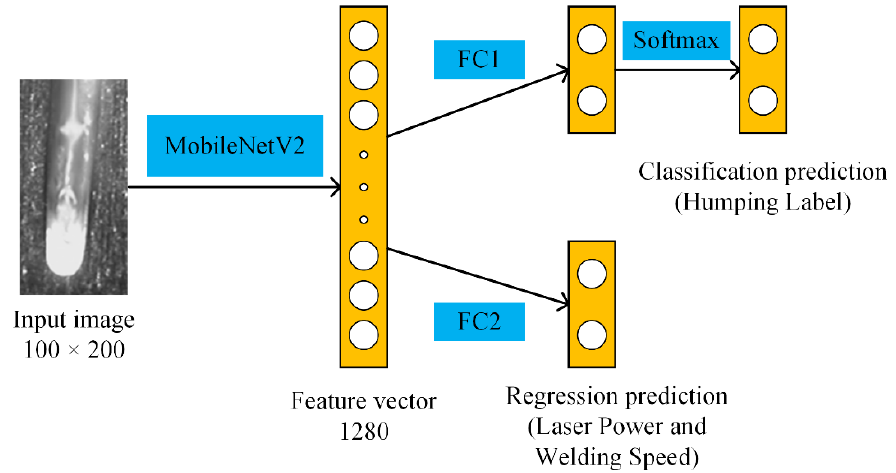
Figure 3. Architecture of MobileNetV2-C&R.